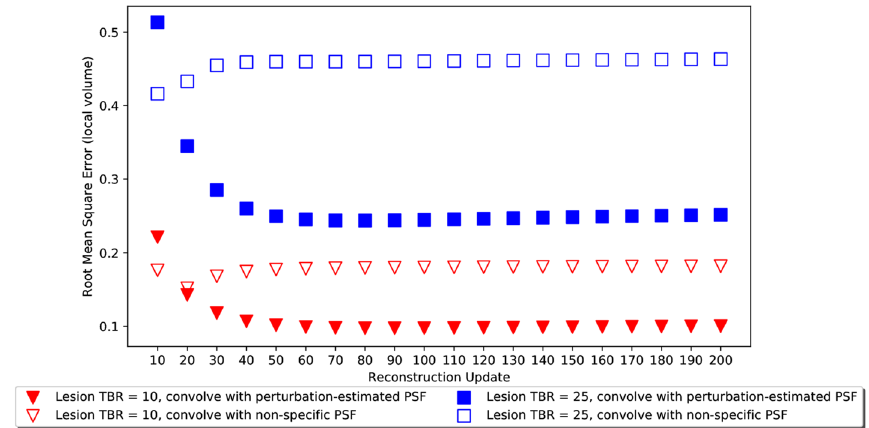
Fig. 6 RMSE results for the 36 mm radius lesion, positioned 8 cm from the isocentre in the noise‑free simple phantom. Results are shown for two different contrast settings, for perturbation‑estimated PSF and a non‑specific